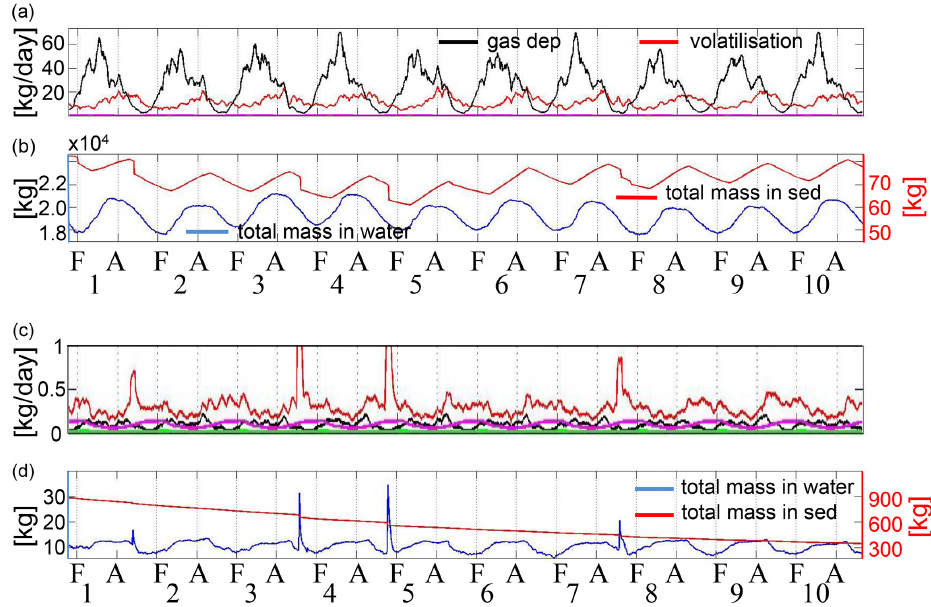
Figure 4. As Fig. 3, but for 2046–2055. Note the different scales (on the left and right) in second and bottom panels showing the different amounts of the substance in water and